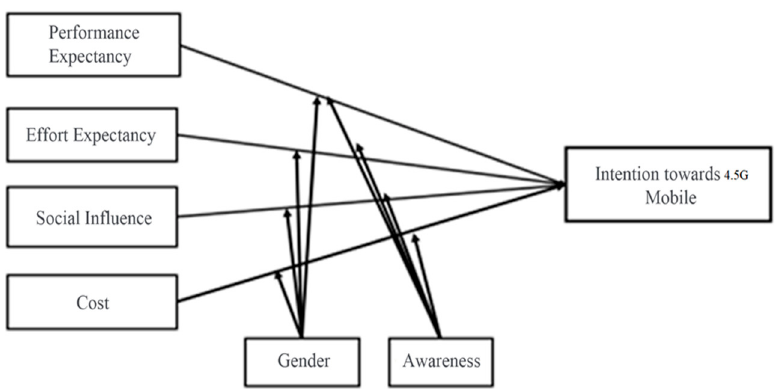
Figure 1. A research model for m-commerce based on the UTAUT model.